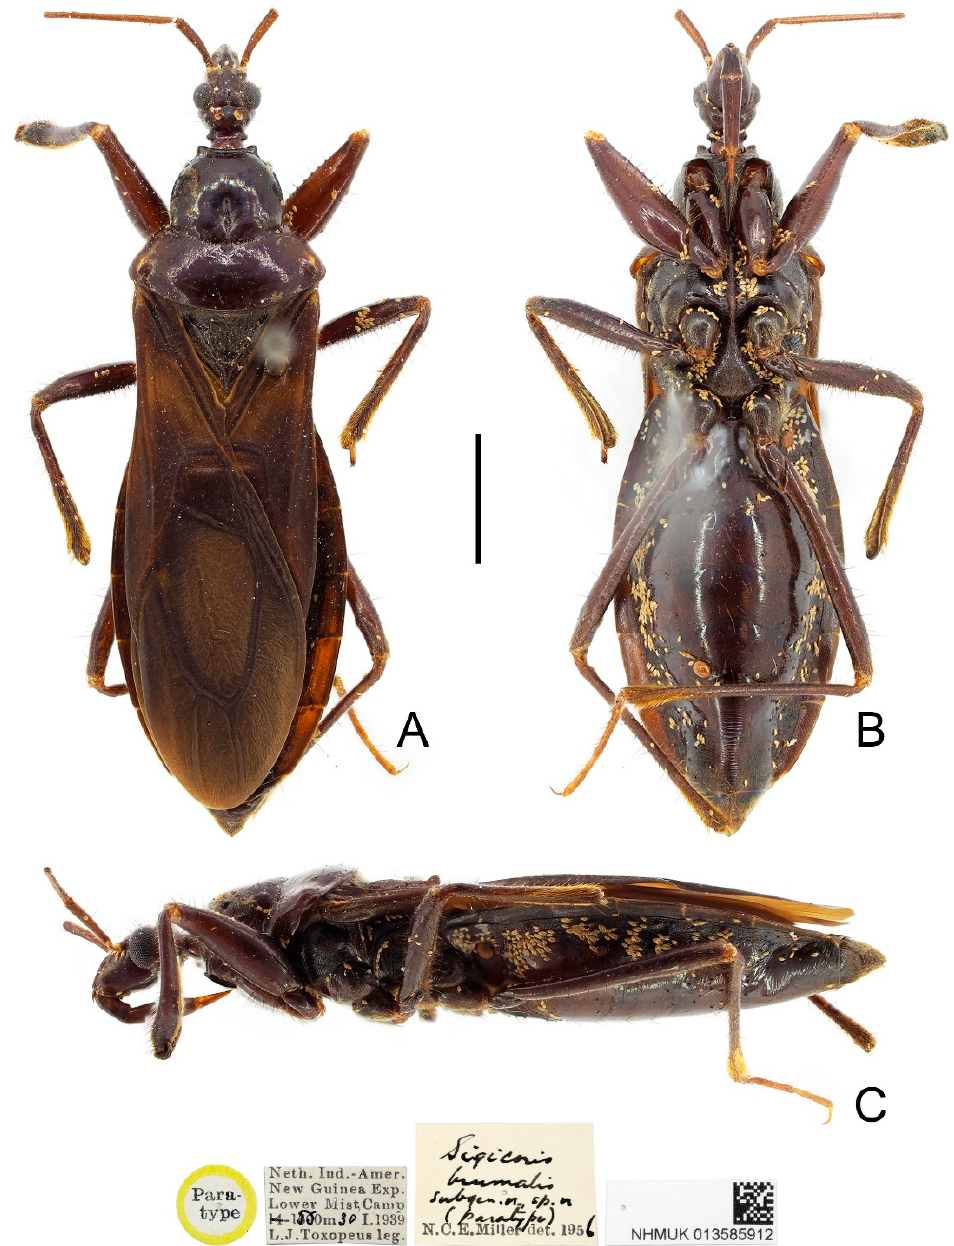
Figure 3. Sigicoris brumalis comb. nov. , paratype female, habitus. ( A ) Dorsal view. ( B ) Ventral view. ( C ) Lateral view. Scale bar = 3.00 mm. Redescription: Macropterous form (Figures 2 and 3). Coloration. Blackish brown. Antennae, third visible segment of rostrum and tarsi brown (Figures 2 and 3); hemelytron dark brown, with most of clavus and area between Pcu and Cu on corium paler, base of costal area of membrane with a diffuse pale brown stripe (Figure